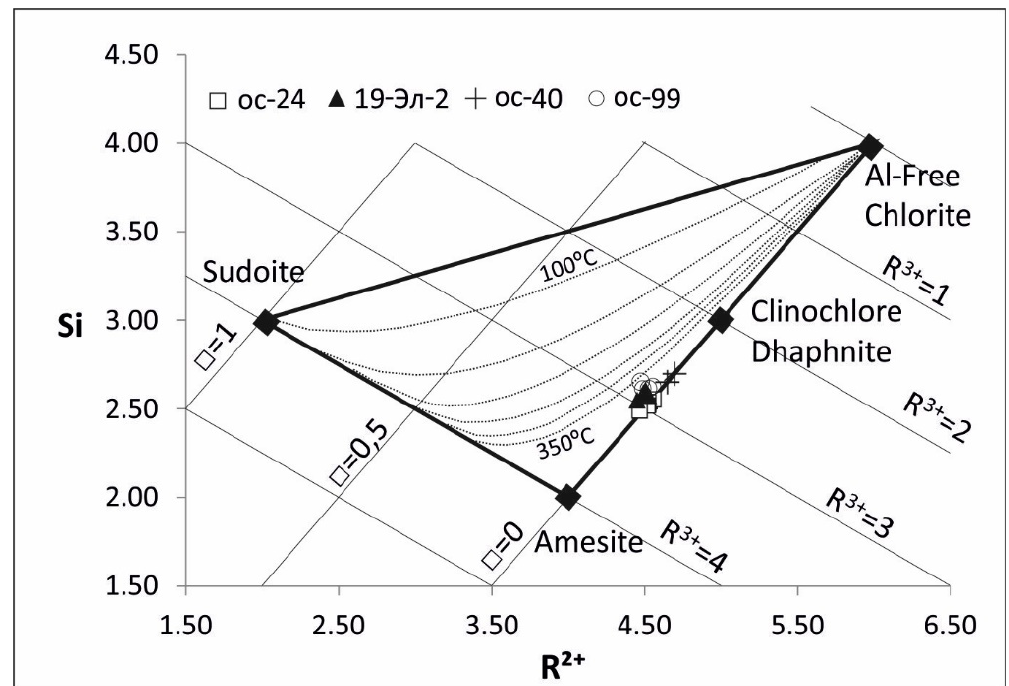
Figure 5. Representation of compositional data set of chlorite in the R 2+ -Si diagram of Wiewiora and Weiss [42]. Isotherms (in 50 °C steps) calculated with Bourdelle et al. [41] geothermometer.